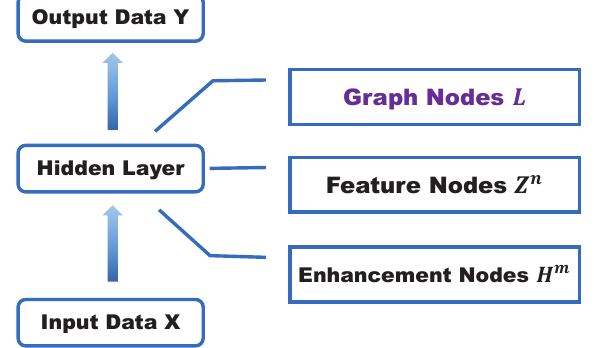
Figure 4. Brief framework of graph-represented broad learning